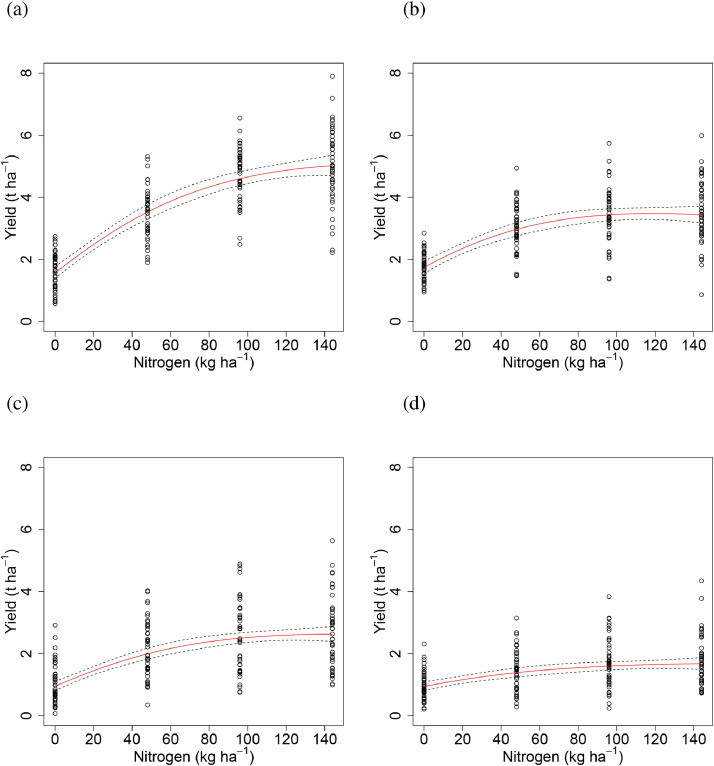
Relationship between spring barley grain yield (○, t ha−1 at 85% dry matter) and applied nitrogen (kg N ha−1) from Series O of the Hoosfield Long Term Experiment from 1968 to 2016 provided by the LEXP function (fitted curve, Eq. (1)) for mineral fertilizer treatments (a) PKNaMg, (b) P, (c) KNaMg and (d) Nil for all years combined (r = 0. 985 (0.0076), fitted curve – red – ±95% Confidence intervals for the curve – dashed). The fitted values of parameters a, b and c are provided in Supplementary Table 2. Analyses were conducted on the square-root transformed data and the fitted functions back-transformed in this figure.